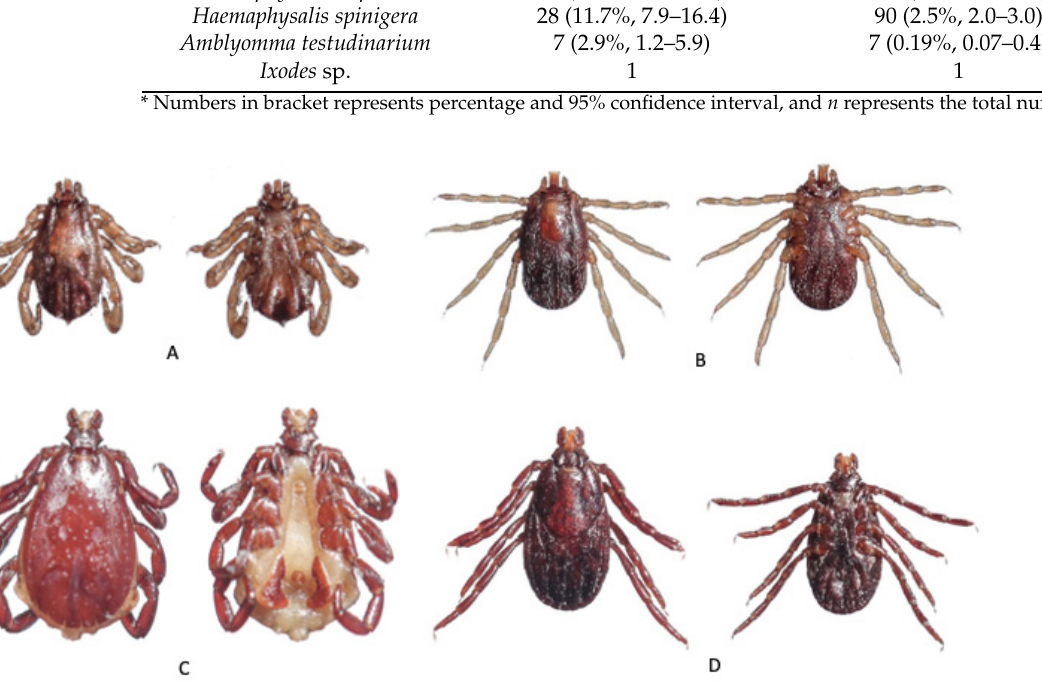
Figure 2. Dorsal and ventral views of male ( A ) and female ( B ) Rhipicephalus microplus ; and male ( C ) and female ( D ) Rhipicephalus haemaphysaloides .